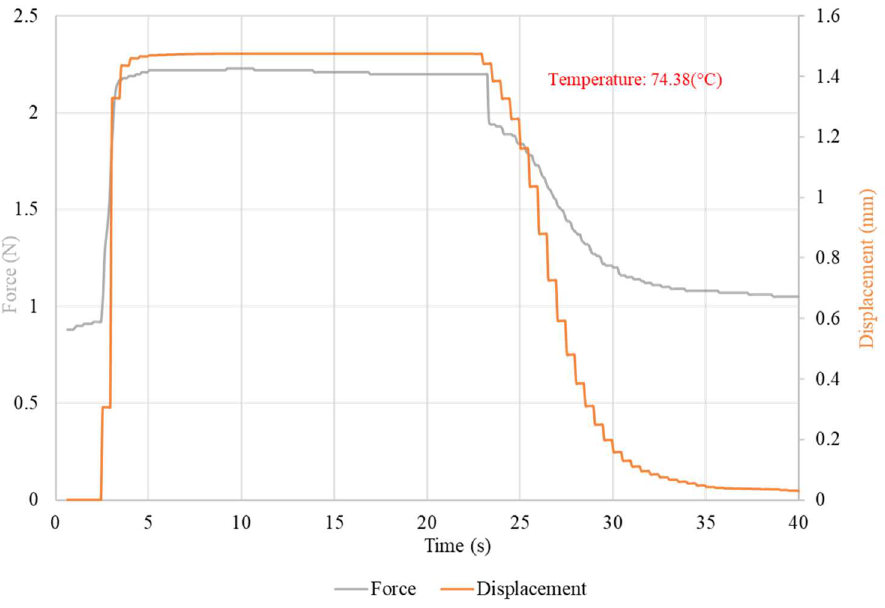
Figure 6. Waveform of the measurement with a 410 mA heating current with the average temperature of the heated sample. Sample diameter, 150 μm.